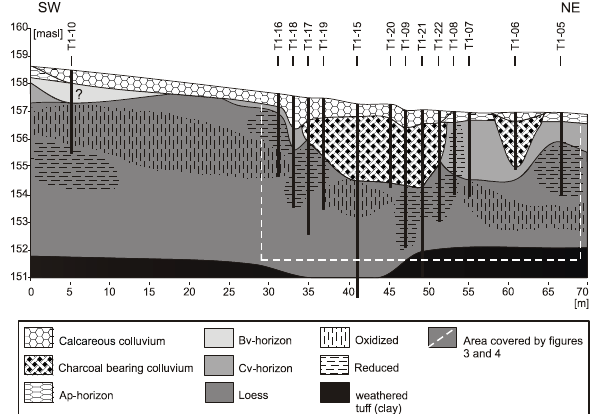
Figure 3. Cross section of reconstructed soil layers of a slope in the Pleiser Hügelland near Bonn (Löwner et al., 2005) Storage capacity in the form of colluvial footslopes is common in many landscapes. Bork (1988) describes basal colluvium deposits in many parts of central and northern Germany, typically formed as a result of diffuse soil erosion. Temporary storage of sediment on slopes is also common, but would perhaps not generally be expected on such a short slope with an undercutting channel, such as in this case.